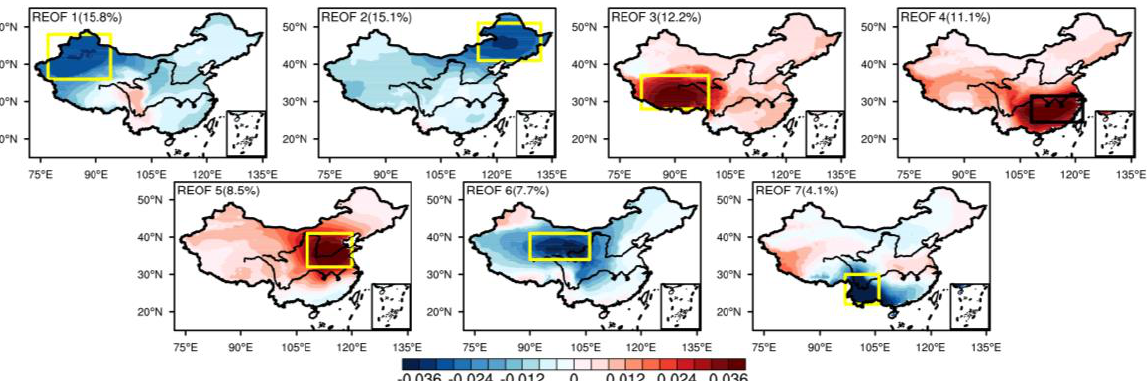
Figure 1. The first 7 REOF modes of daily Tmax minus threshold in the extended summer (May – September) for 1981 – 2018 . The boxes represent the seven subregions, respectively, of which the black box represents the Jiangnan region (24.5° – 31.5° N, 108° – 122° E).